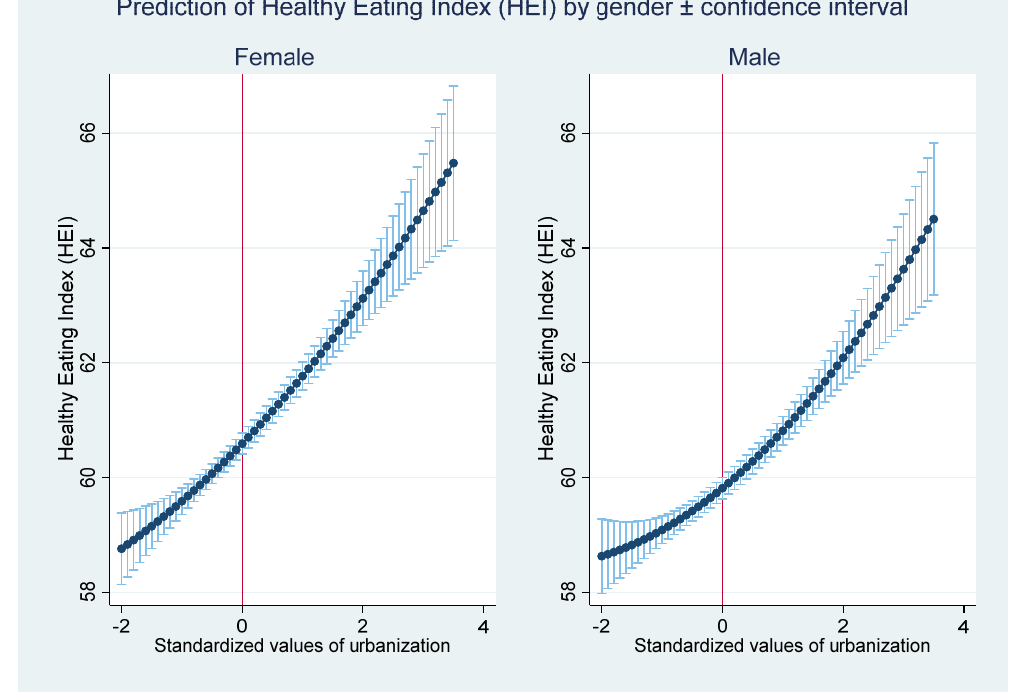
Figure 5. The relationship between urbanization and the predicted Healthy Eating Index (HEI) by gender.